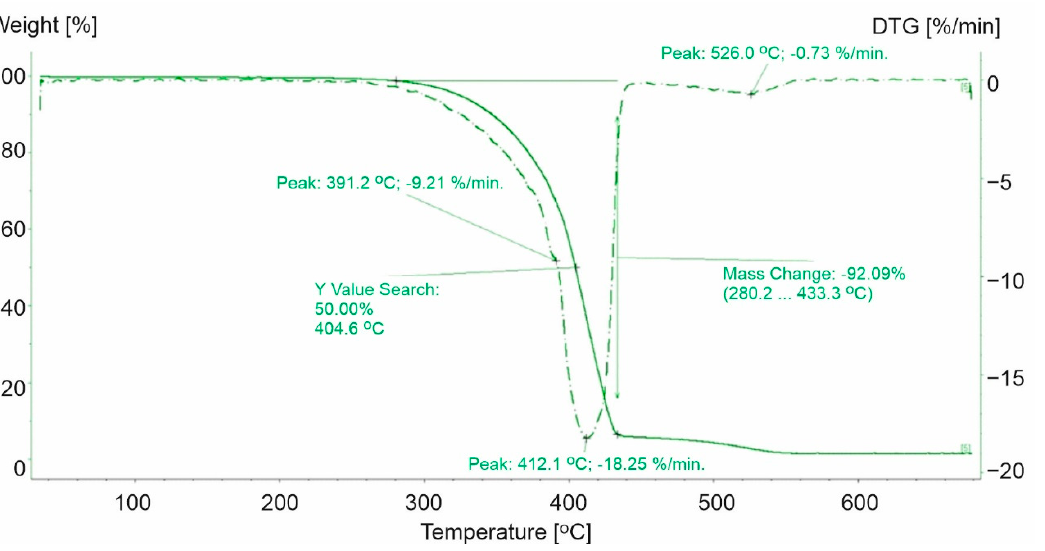
Figure 8. TG and DTG curves for PS ‐ 1. The green line presents TG curve, while the green dot line presents DTG curve. Table 3. Selected parameters for the thermal decomposition process for polystyrene.